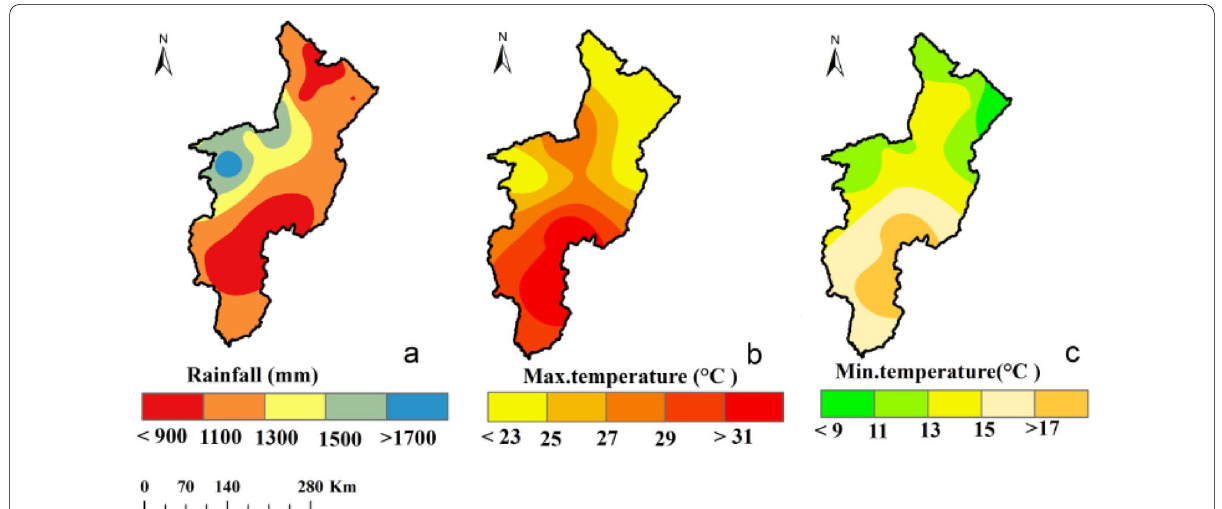
Fig. 2 The spatial distribution of the mean a annual rainfall, b annual maximum temperature, and c annual minimum temperature in OGRB from 1981 to 2017